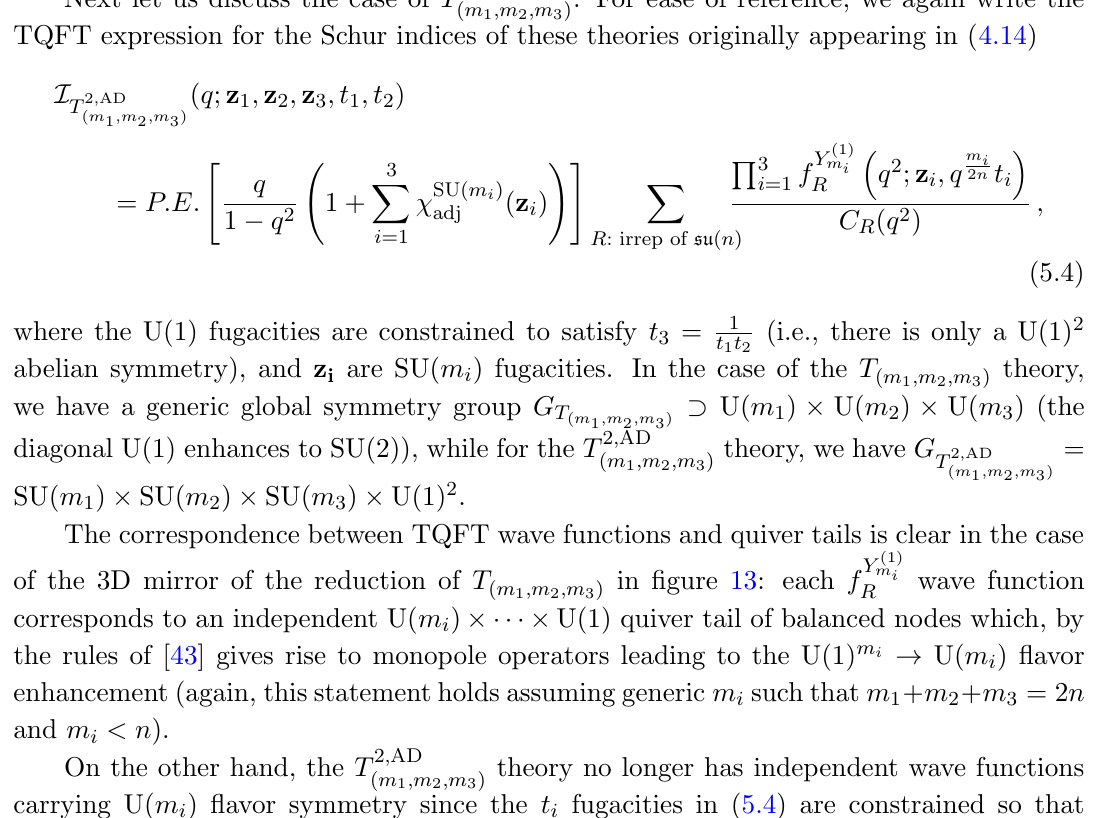
Figure 13 . The 3D mirror of the S 1 reduction of the T de(cid:12)ned as in (cid:12)gure 11. The three quiver tails correspond to TQFT wave functions carrying U( m i ) global